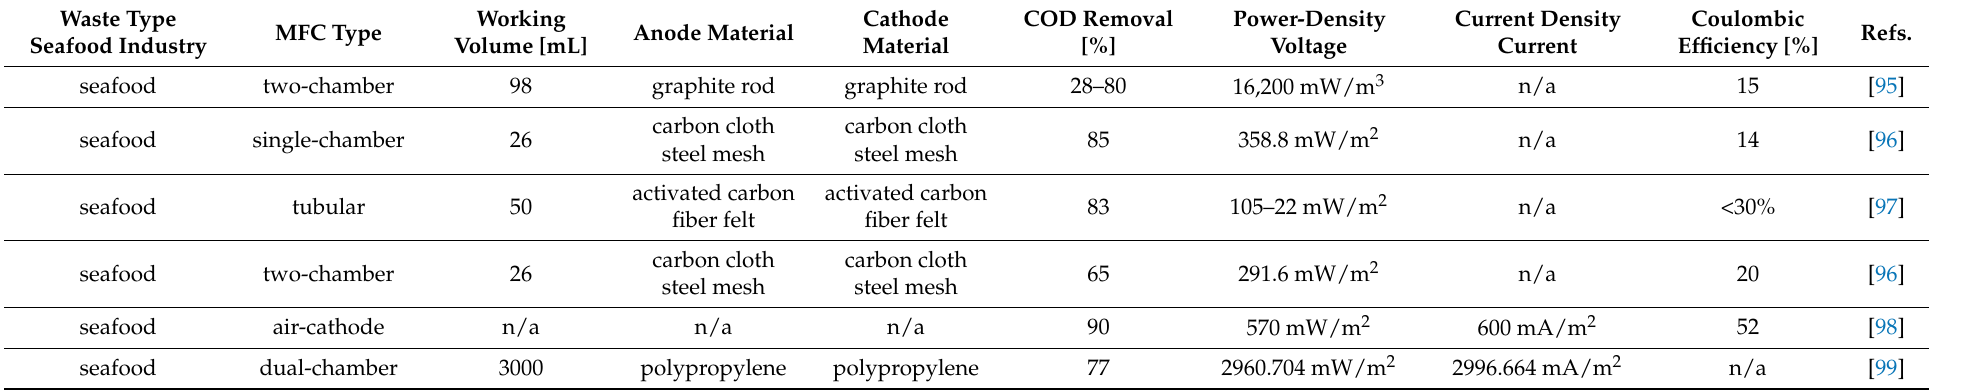
Table A2. Summary of studies reporting use of seafood waste in